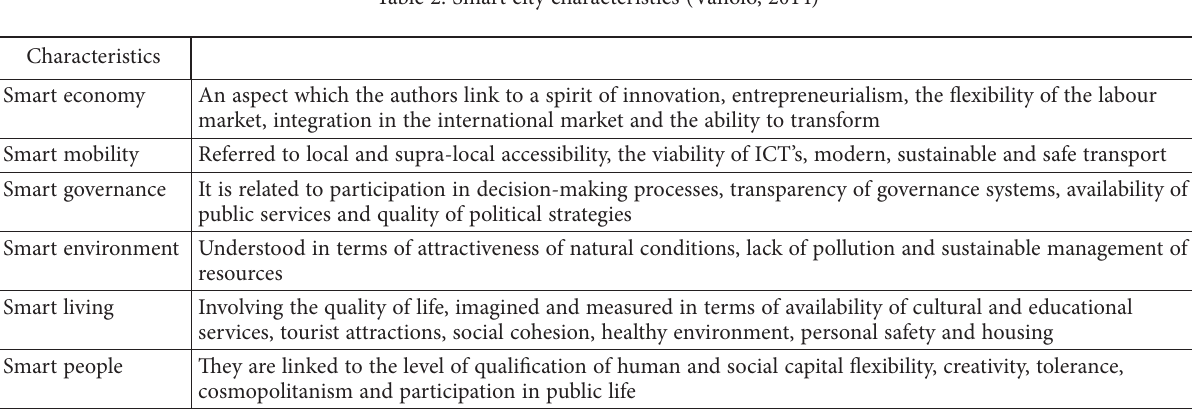
Table 2. Smart city characteristics (Vanolo,